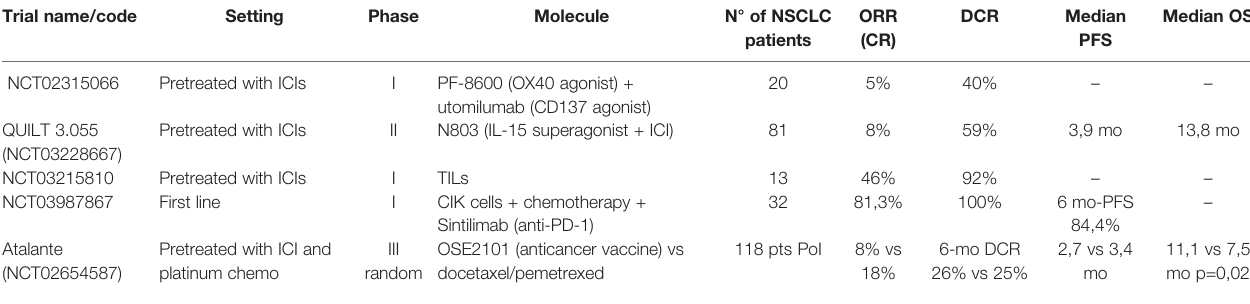
TABLE 2 | Results of clinical trials for new agents targeting co-stimulatory molecules on T cells and cellular therapy.